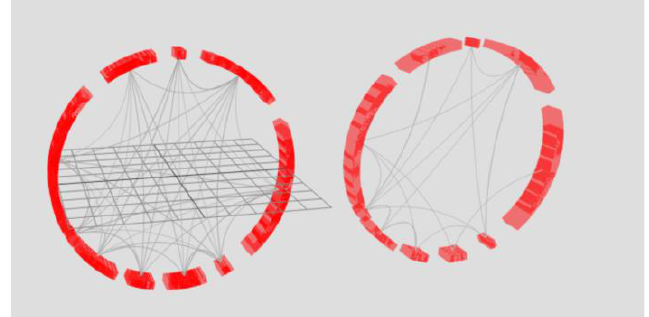
Figure 15. Combination of rings of